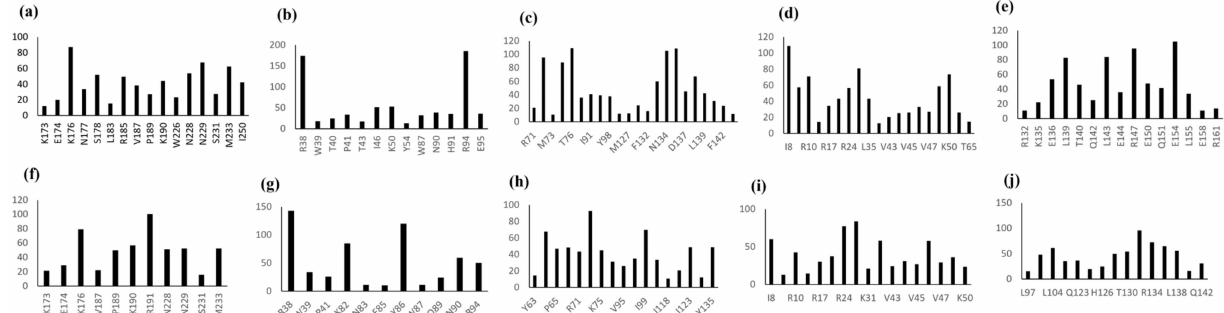
Figure 5. List of the residues for the interaction partners of BBM that showed ∆ SASA (solvent accessible surface area) > 0 in the best-docked complexes ( a ) BBM frag1-LEC2, ( b ) BBM